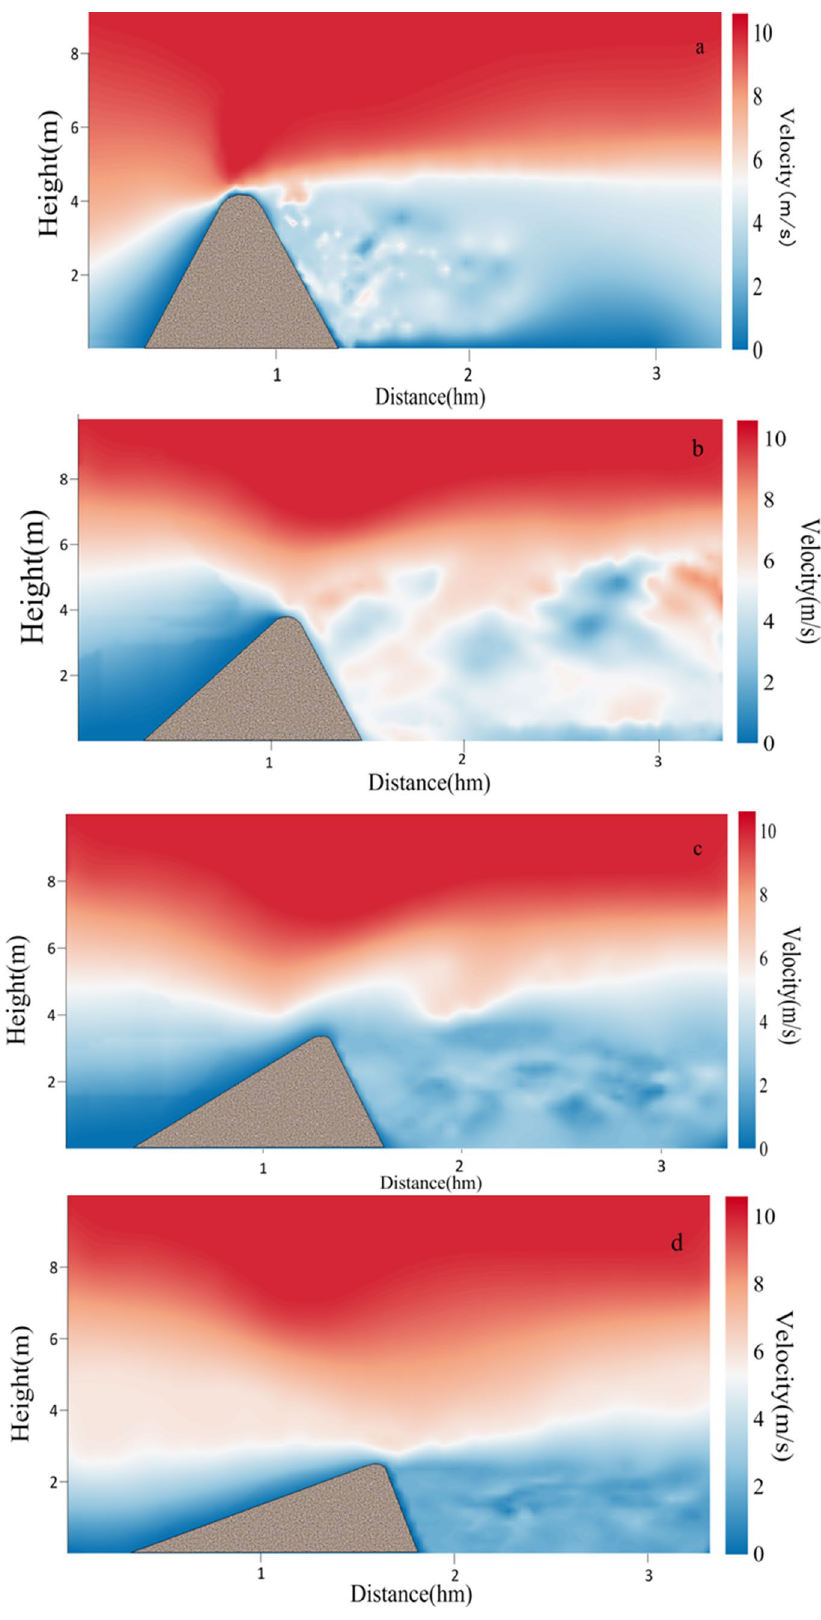
Figure 1. The simulated two-dimensional wind fields at the position of the central axis during the evolution into a crescentic dune. ( a – d ) represented the two-dimensional wind field at the position of the central axis of the four stages, respectively. The map was plotted using Matlab 2014a (https ://www.mathw